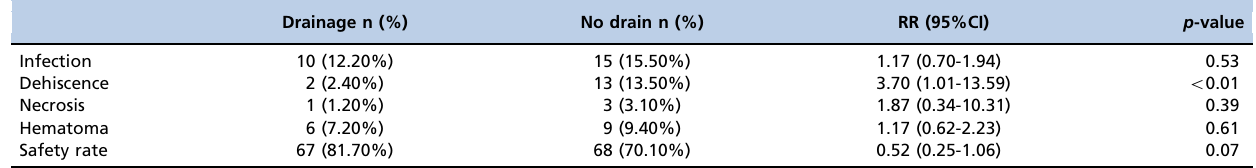
Table 3 - Analysis of the complications observed according to group (axillary drainage or no drain).